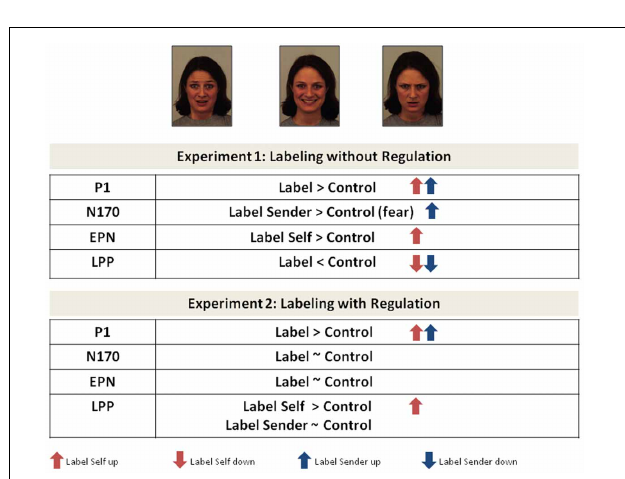
FIGURE 3 | ERPs obtained during emotional face processing in experiment 2 (affect labeling with intentional regulation instruction). Passive viewing of emotional faces (black line). Upper left panel (A) displays ERP modulation patterns in the early time-windows (P1, N170, and EPN, respectively). Upper right panel (B) displays amplitude modulation of the